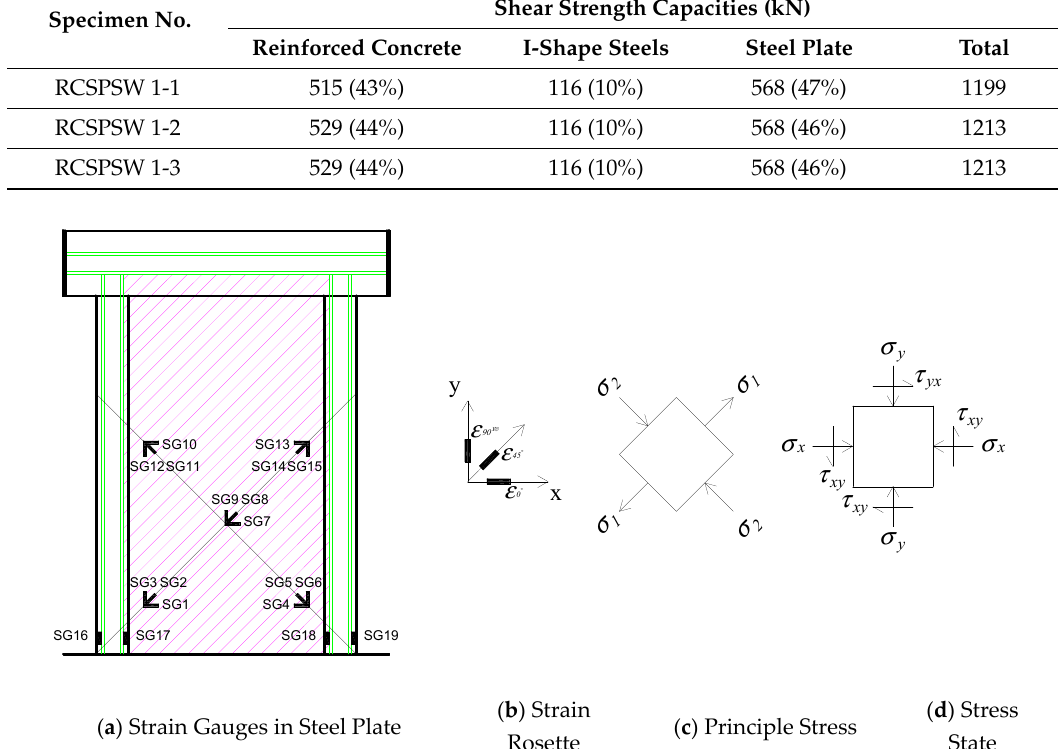
Table 7. Design Strength Capacities Contributed by Different Components in RCSPSW. Specimen No.